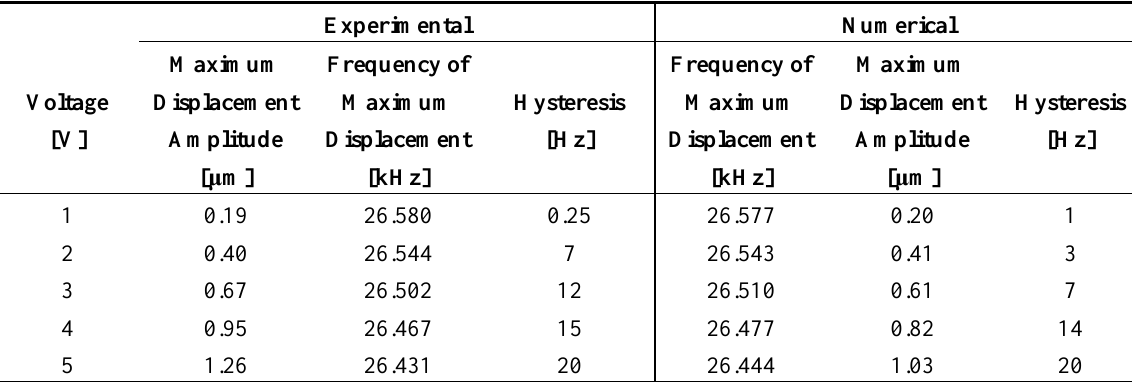
Table 1. Experimental and Numerical results.